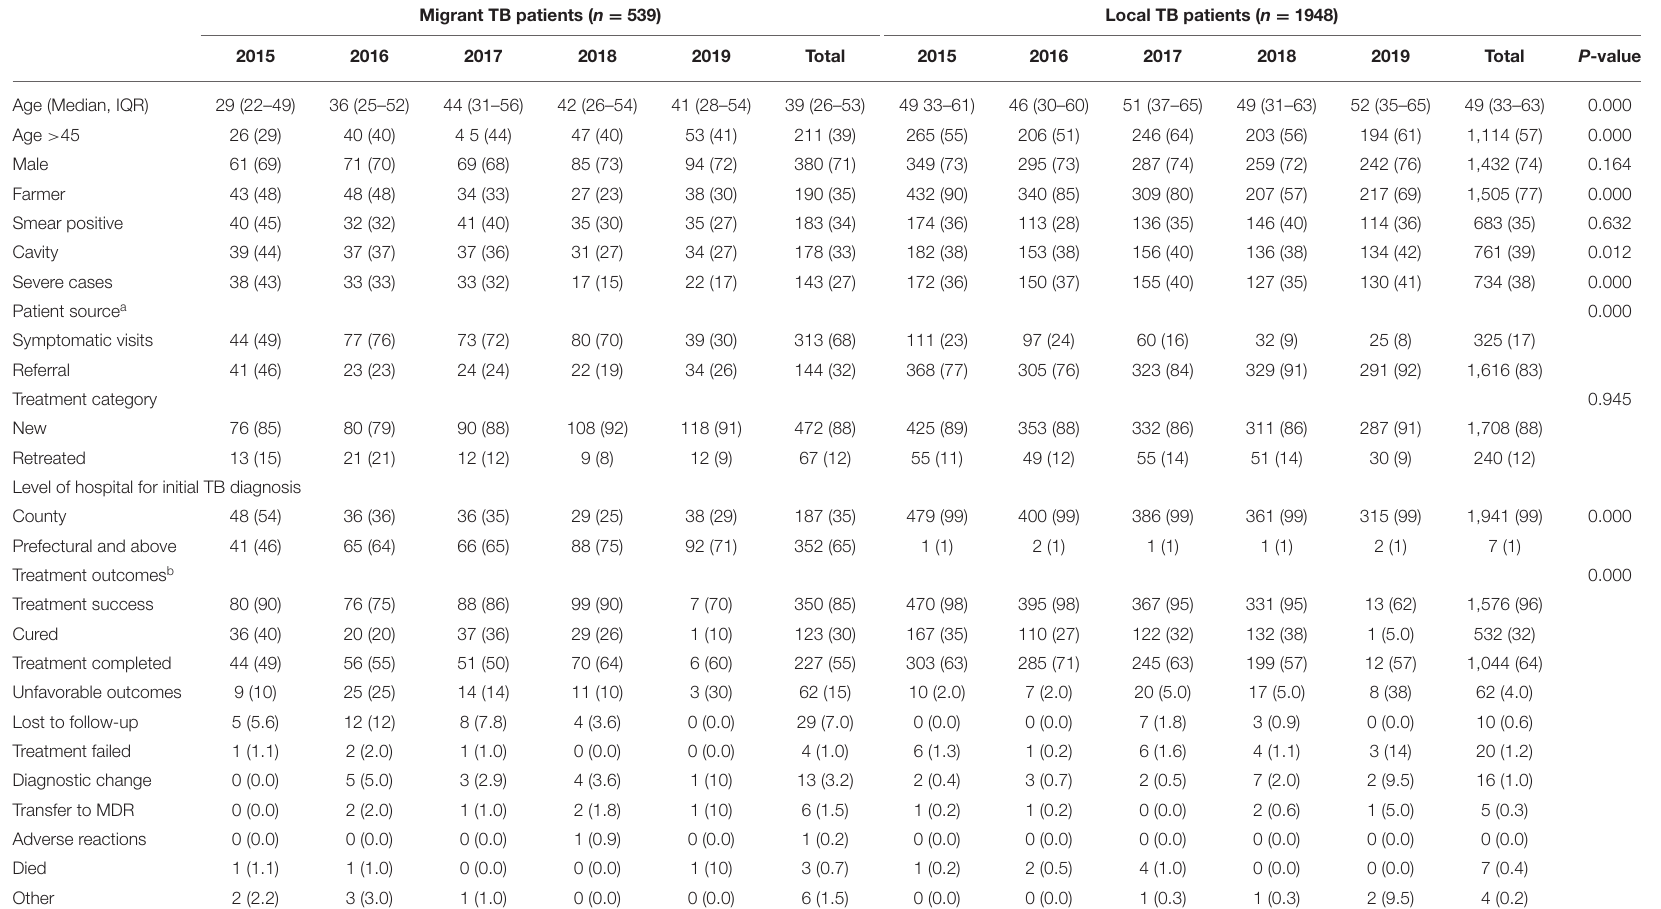
TABLE 1 | Demographics, clinical characteristics of migrant and local patients with TB from 2015 to